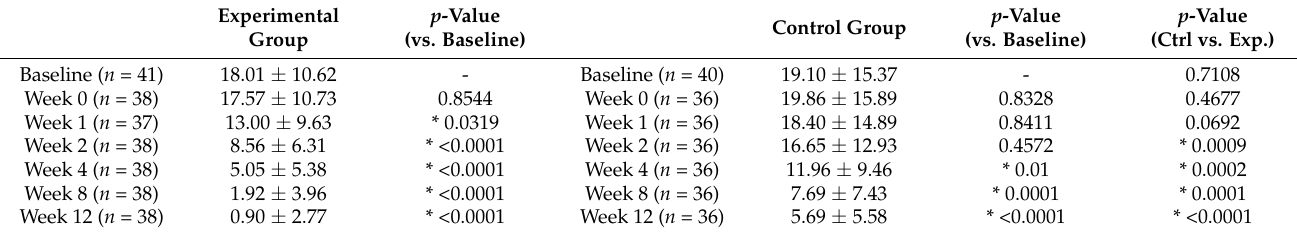
Table 3. Wound area reduction.